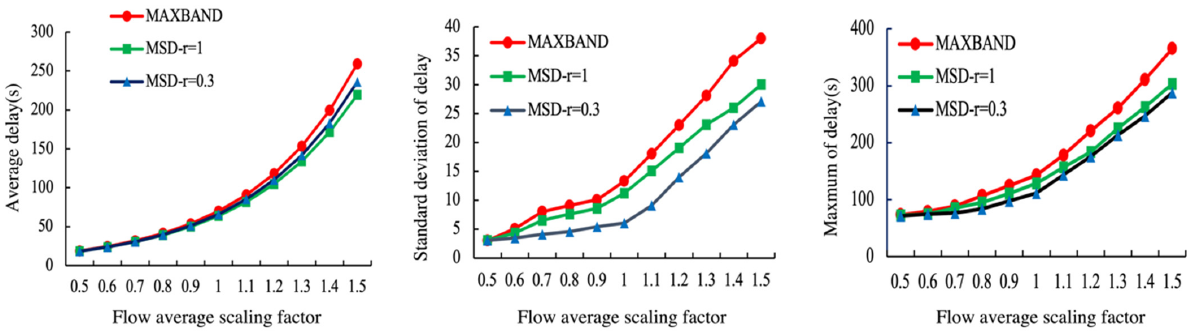
Figure 15. Effect of traffic flow on delay index.